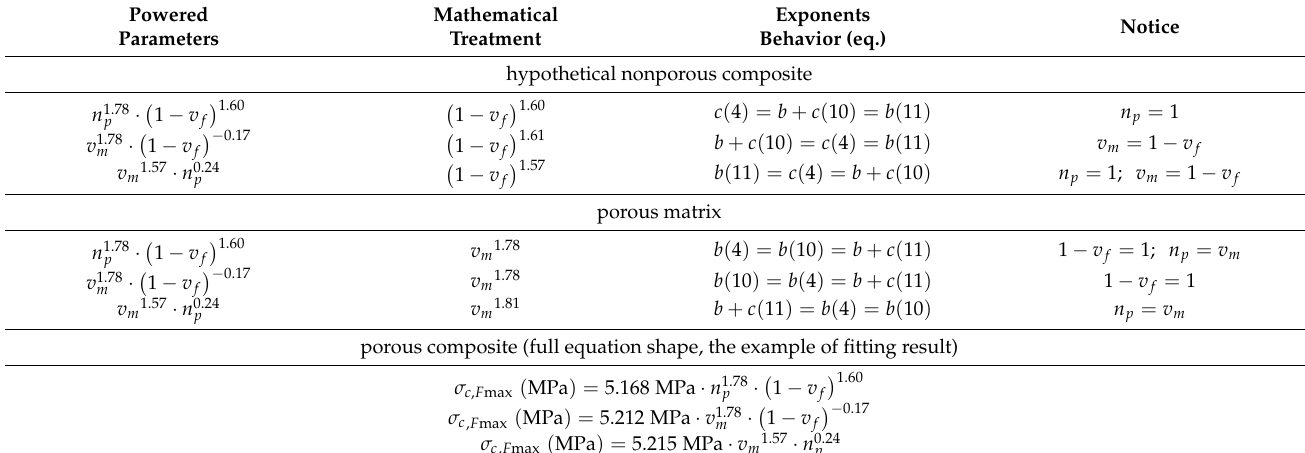
Table 6. Mathematical behavior of structural parameter pairs and their exponents coming from Equations (4), (10) and (11). The behavior is shown by the example of data fitting connecting the composites based on P 95 -G 5 matrix and their values of ultimate strength. The behavior of exponents could also be supplemented by Equation c (11) = − b (10) = b − c (4), that is not in the table due to a missing connection to equation simplification if the material is also